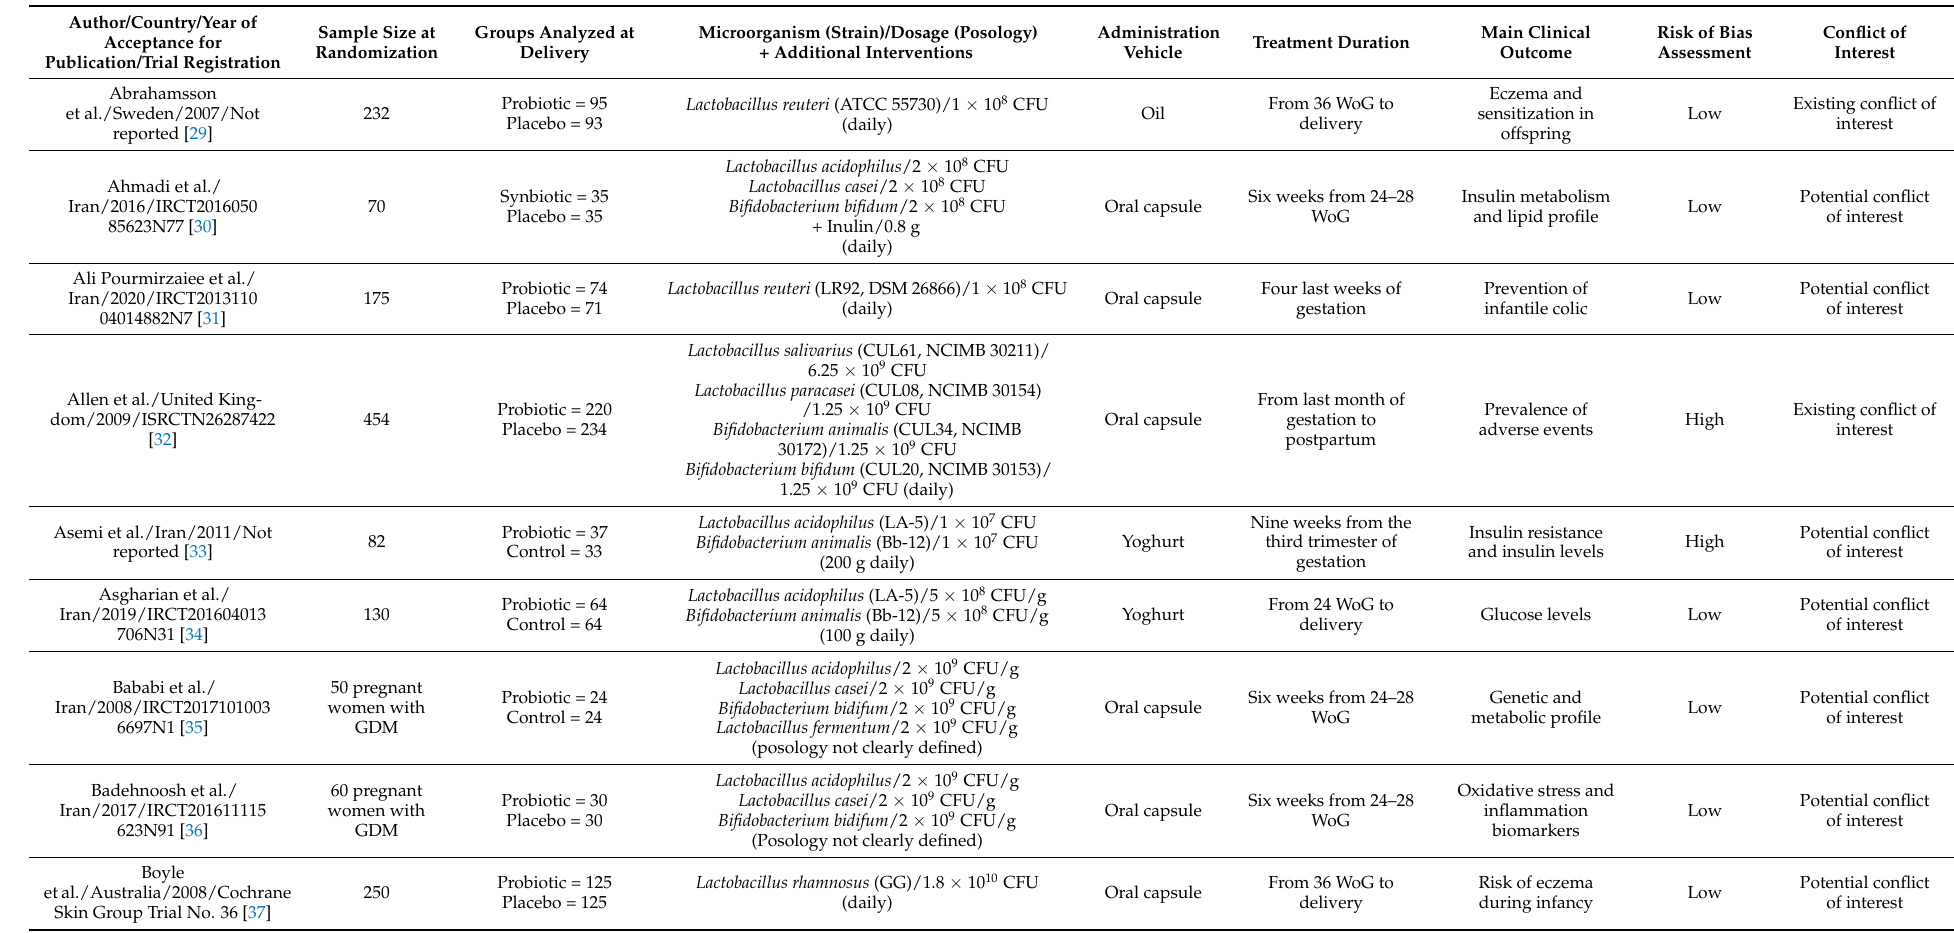
Table 1. Characteristics of the included